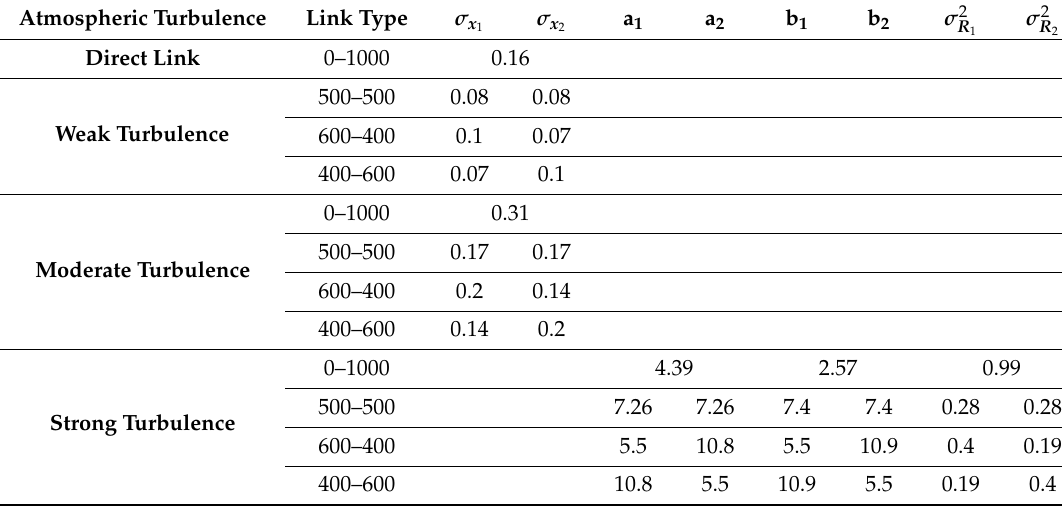
Table 2. ATMOSPHERIC